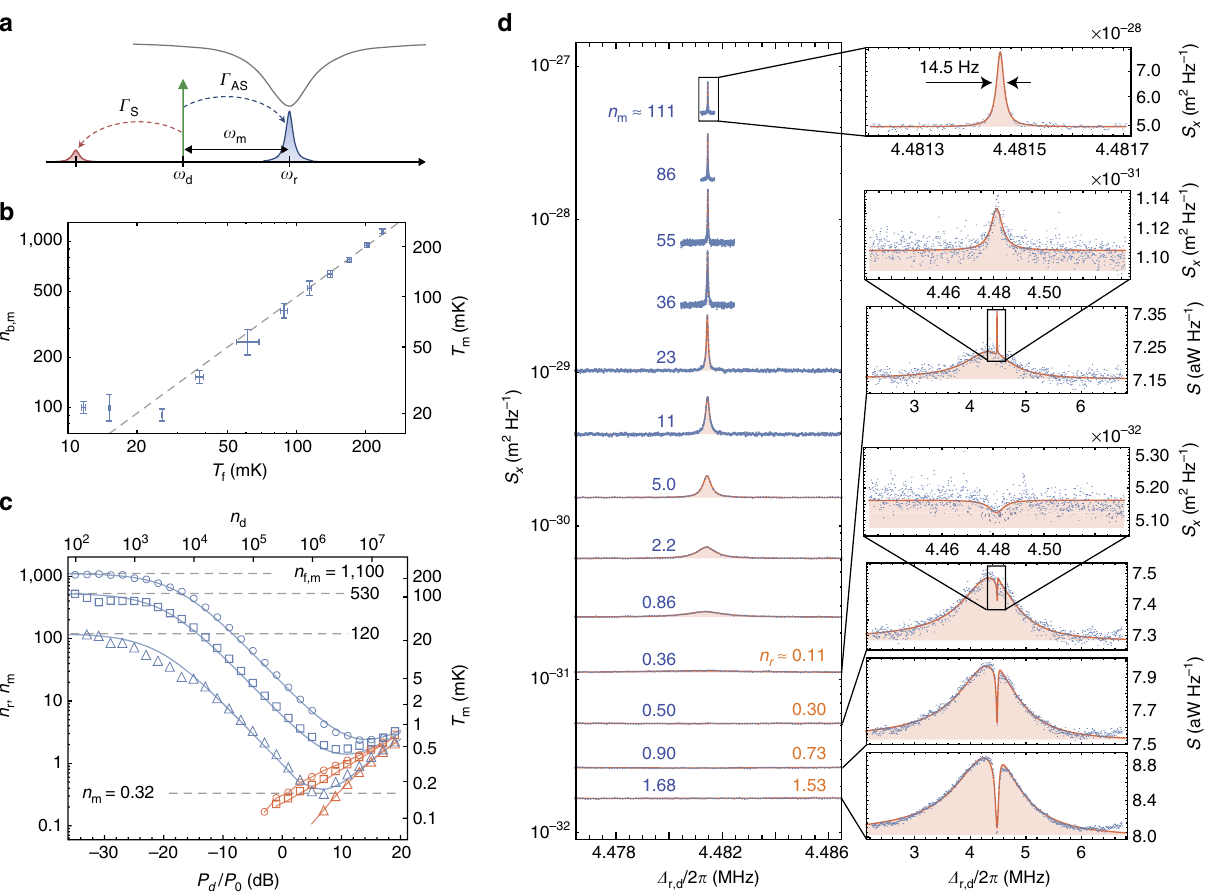
Figure 4 | Mechanical displacement noise. ( a ) Schematic showing the pump detuning and scattered microwave signals used to measure the mechanical resonator’s displacement noise. ( b ) Plot of the measured mechanical resonator bath phonon occupation ( n b,m ) and effective temperature ( T m ) as a function of the fridge temperature ( T f ). Each data point corresponds to the average inferred occupancy for blue detuned driving ( D r,d ¼ (cid:3) o m ) at low cooperativity ( C oo 1). Error bars corresponding to the s.d. in the inferred occupancy over several temperature sweeps. Calibration in units of occupancy is performed using a fit to equation (3) as described in the main text and Supplementary Notes 6–8. The grey dashed lines show the expected Bose–Einstein distribution ð n m ¼ ð exp ð (cid:2) hw m Þ(cid:3) 1 Þ (cid:3) 1 Þ assuming perfect thermalization to the fridge. ( c ) Plot of the dynamic backaction cooling of the mechanical resonator k B T f versus drive power ( P 0 ¼ 1mW) at three different fridge temperatures: T f ¼ 235mK ( n f , m ¼ 1100; open circles), T f ¼ 114mK ( n f , m ¼ 530; open squares) and T f ¼ 26mK ( n f , m ¼ 120; open triangles). Data points showing the estimated average phonon occupancy of the fundamental in-plane flexural mode at o m /2 p E 4.48MHz ( n m ) are shown as blue symbols, whereas data points for the estimated microwave cavity photon occupancy at o r /2 p ¼ 7.498GHz ( n r ) are shown as orange symbols. The corresponding effective mode temperature, T m , of the flexural mechanical mode is also shown on the right vertical axis. The solid line blue curves correspond to a model for the expected mechanical mode occupancy using a fit to the measured drive power relation for G and the microwave cavity parameters from coherent two-tone spectroscopy, the intrinsic mechanical damping from low power thermometry measurements and a fit to the power dependence of the microwave resonator occupancy. ( d ) Measured anti-Stokes noise displacement spectrum for several different drive powers at T f ¼ 26mK (blue data points). Fits to the measured spectra are shown as red solid lines (see Supplementary Note 6 for fit model). Extracted values for n m and n r are indicated and correspond to the results presented in c . Zoom-ins of the cavity noise and measured noise peaks are shown as